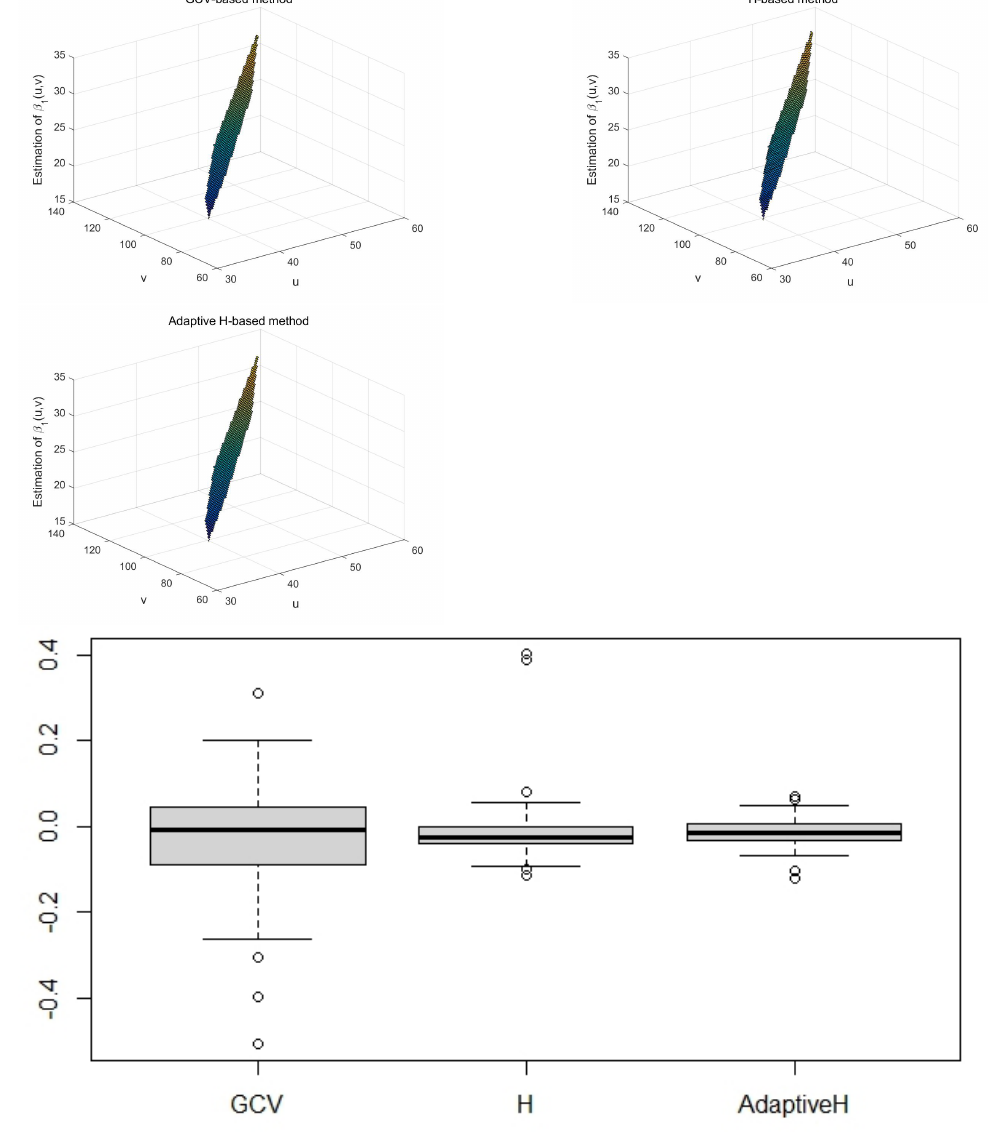
Figure 2. The estimated surface of β 1 ( u , v ) ( top row ) and residuals boxplots ( bottom row ) with the GCV − based method ( left panel ), the bandwidth matrix H ( middle panel ) and the adaptive bandwidth matrix H method ( right panel